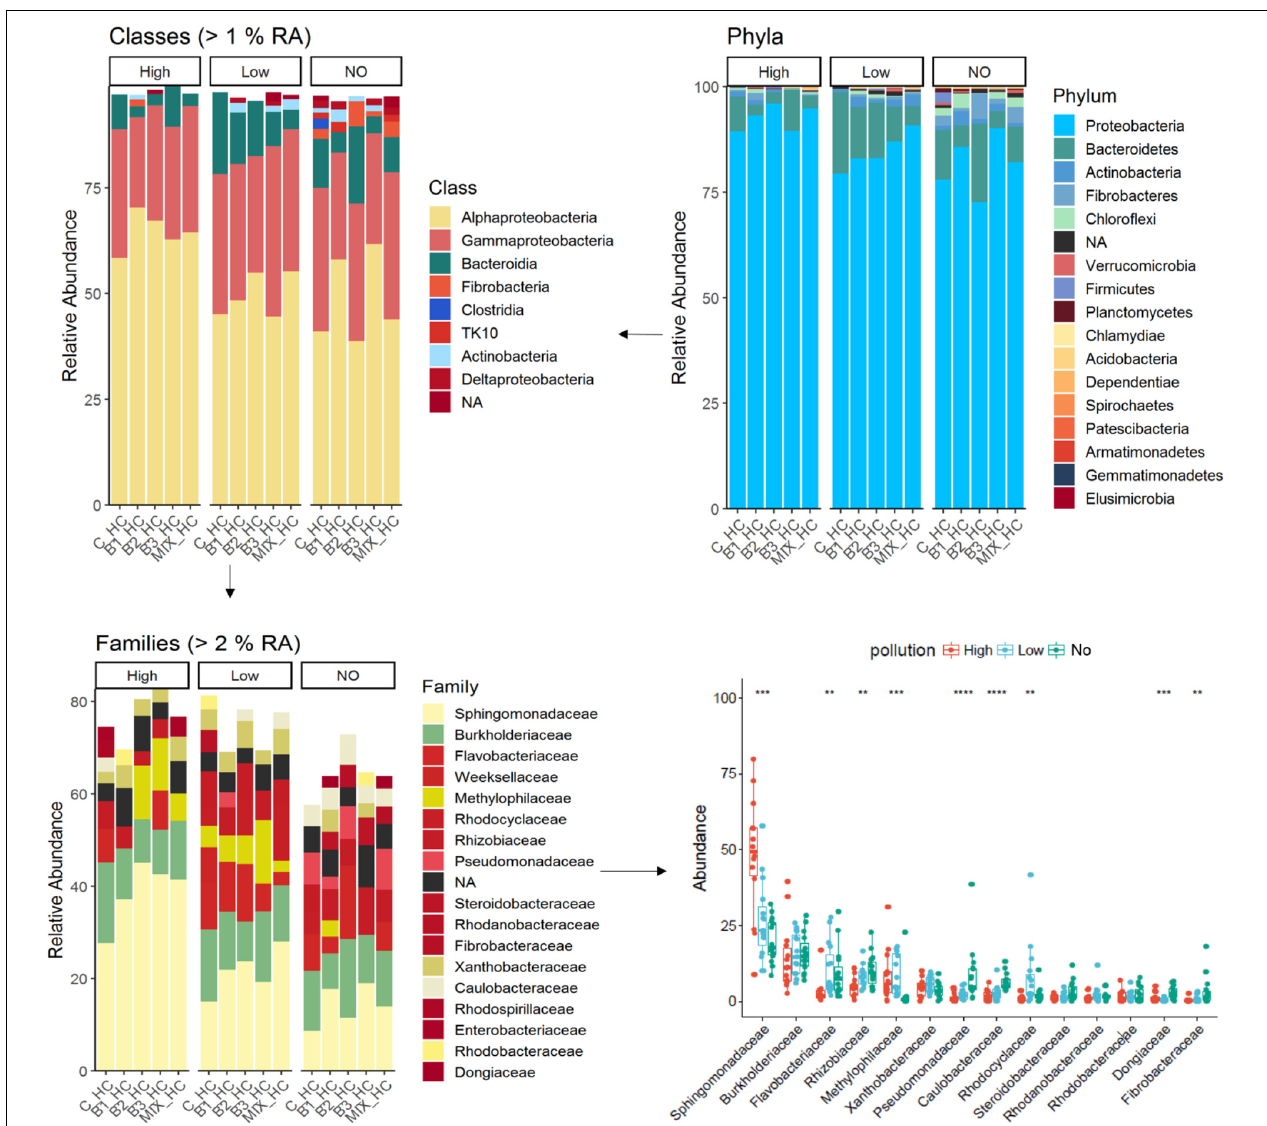
FIGURE 3 | Overview of the relative populations of root endophytes with respect to phylum, class, and family under the different level of